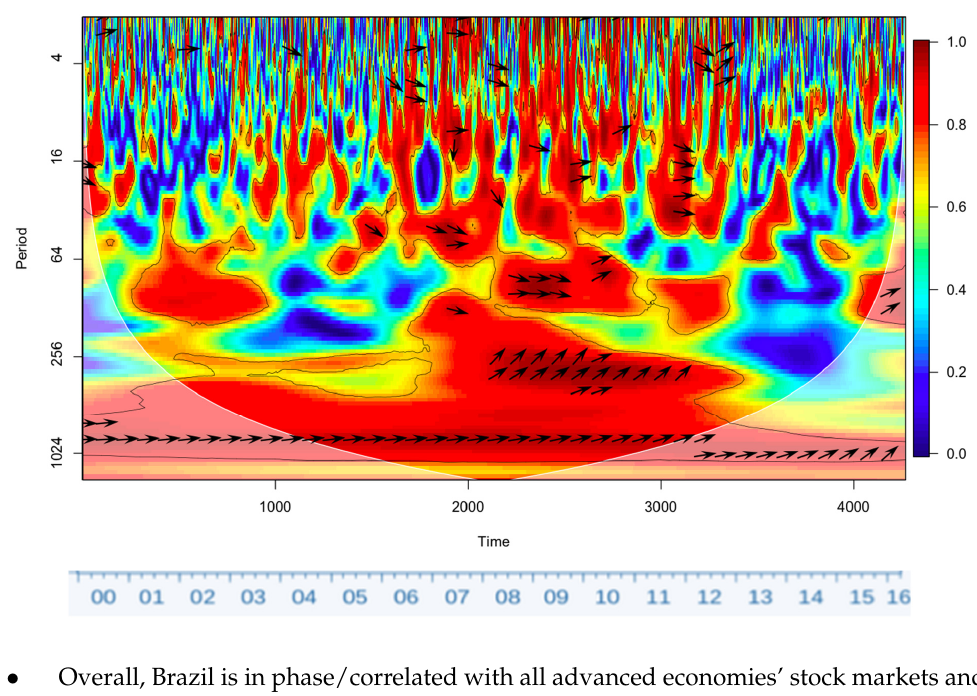
sented using a heat map, which ranges from blue (low power) to red (high power). Re- gions of differing coherency are represented using a heat map, which ranges from blue (low coherency) to red (high coherency). Phases/arrows are to be interpreted as follows: arrows pointing to the right mean that x and y are in phase; arrows pointing to the left mean that x and y are out-of-phase; arrows pointing up mean that y leads x by 90 degrees; and arrows pointing down mean that x leads y by 90